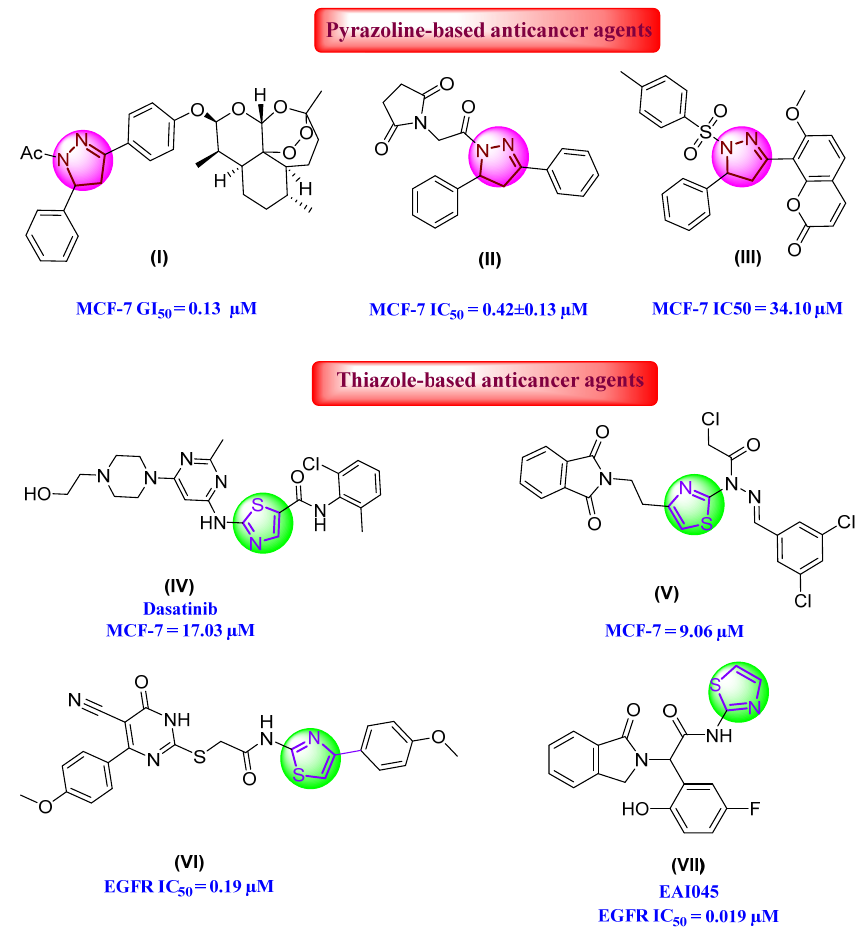
Figure 2. Some reported pyrazoline-based and thiazole-based anticancer agents. Rationale of the Work Rationale of the